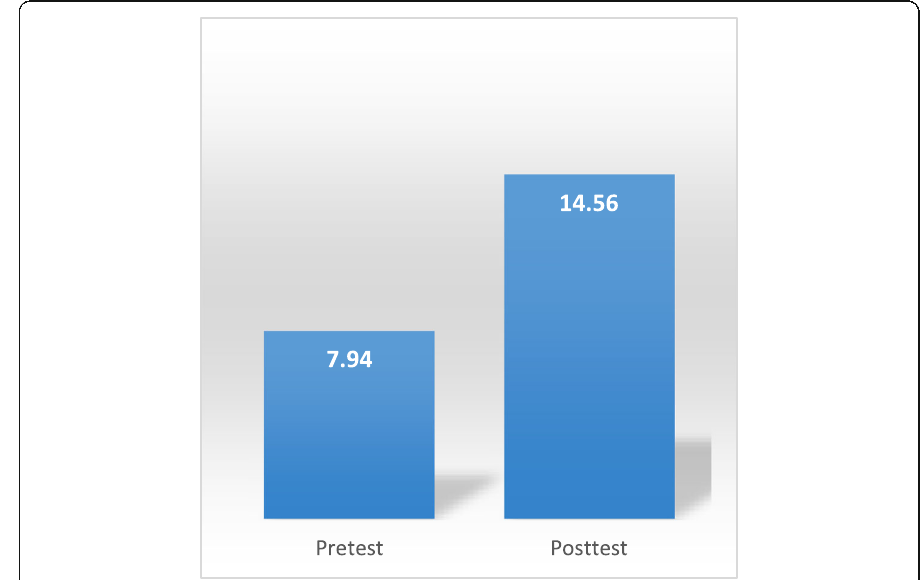
Fig. 1 Pretest and posttest of speech acts (individual